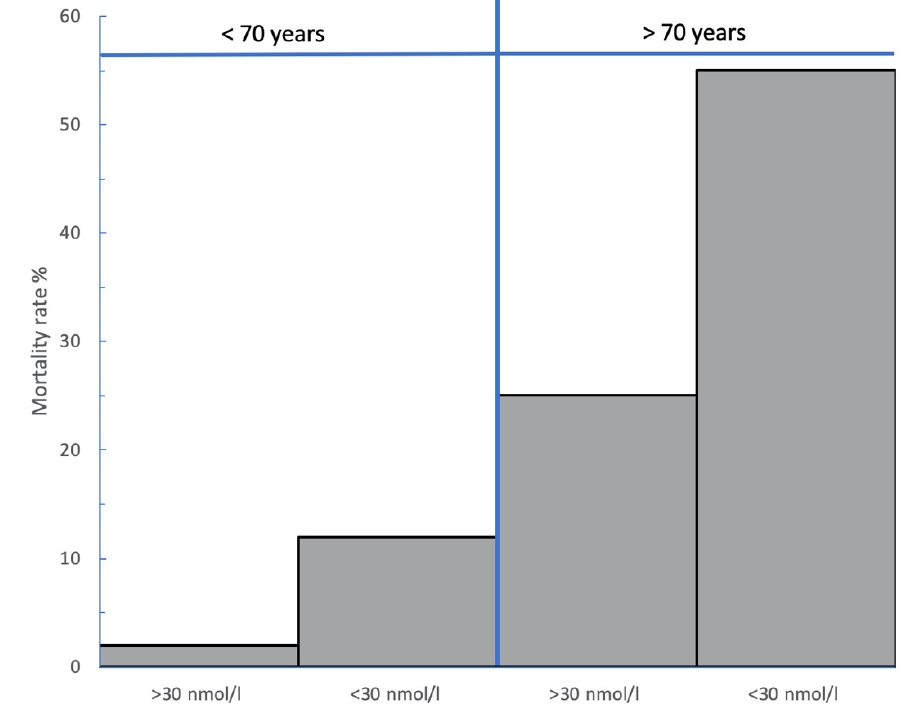
Figure 1. Mortality rates according to age and vitamin D status. The x axis denotes serum vitamin D level (25(OH)D level in nmol·L − 1 ) for subjects younger than 70 years and older than 70 years. The level (25(OH)D level in nmol · L − 1 ) for subjects younger than 70 years and older than 70 years. The y y axis represents % mortality rate. axis represents % mortality